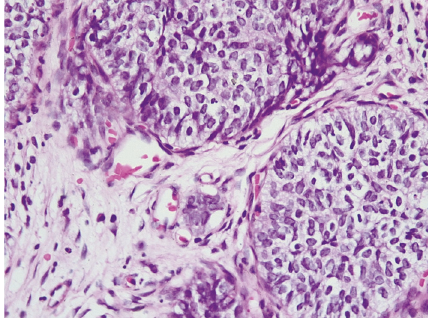
Figure 2: Adamantinoma-like EWS: H&E x400.